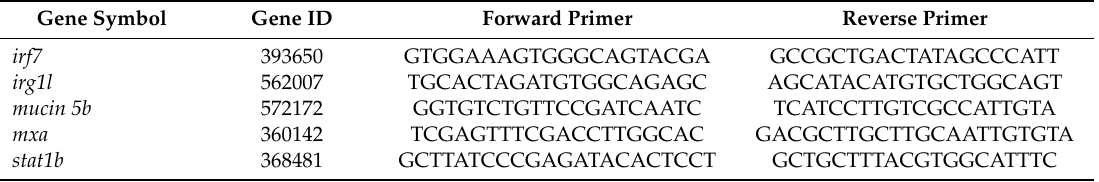
Table 3. List of primers used for qPCR analysis.